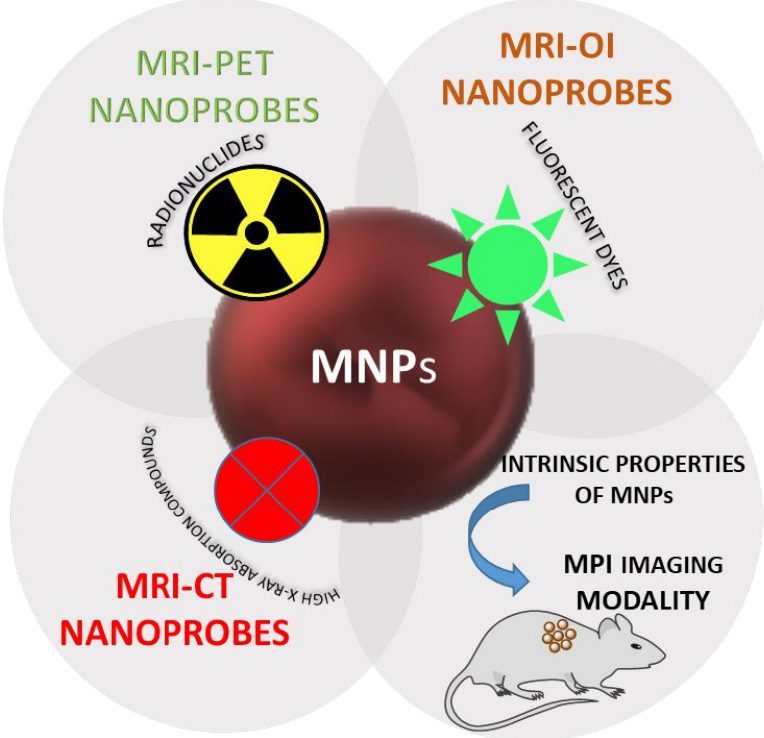
Figure 4. Representation of the capabilities of MNPs to impart multiple diagnostic tools.